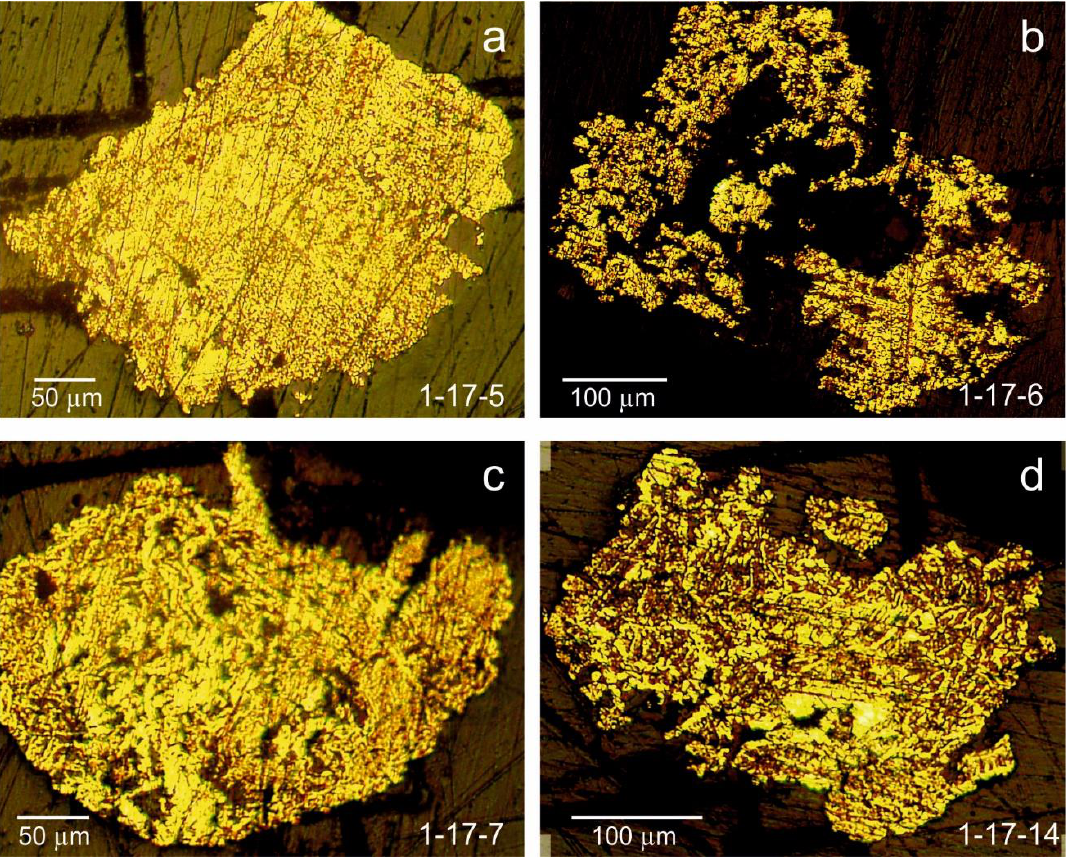
Figure 7. Native gold of the Khokhoy gold ore field, ( a ) microporous spongy-mustard gold, ( b ) framework gold with massive gold in the center, ( c , d ) dendritic mustard gold. Mounted sections, ore microscope, image in reflected light.